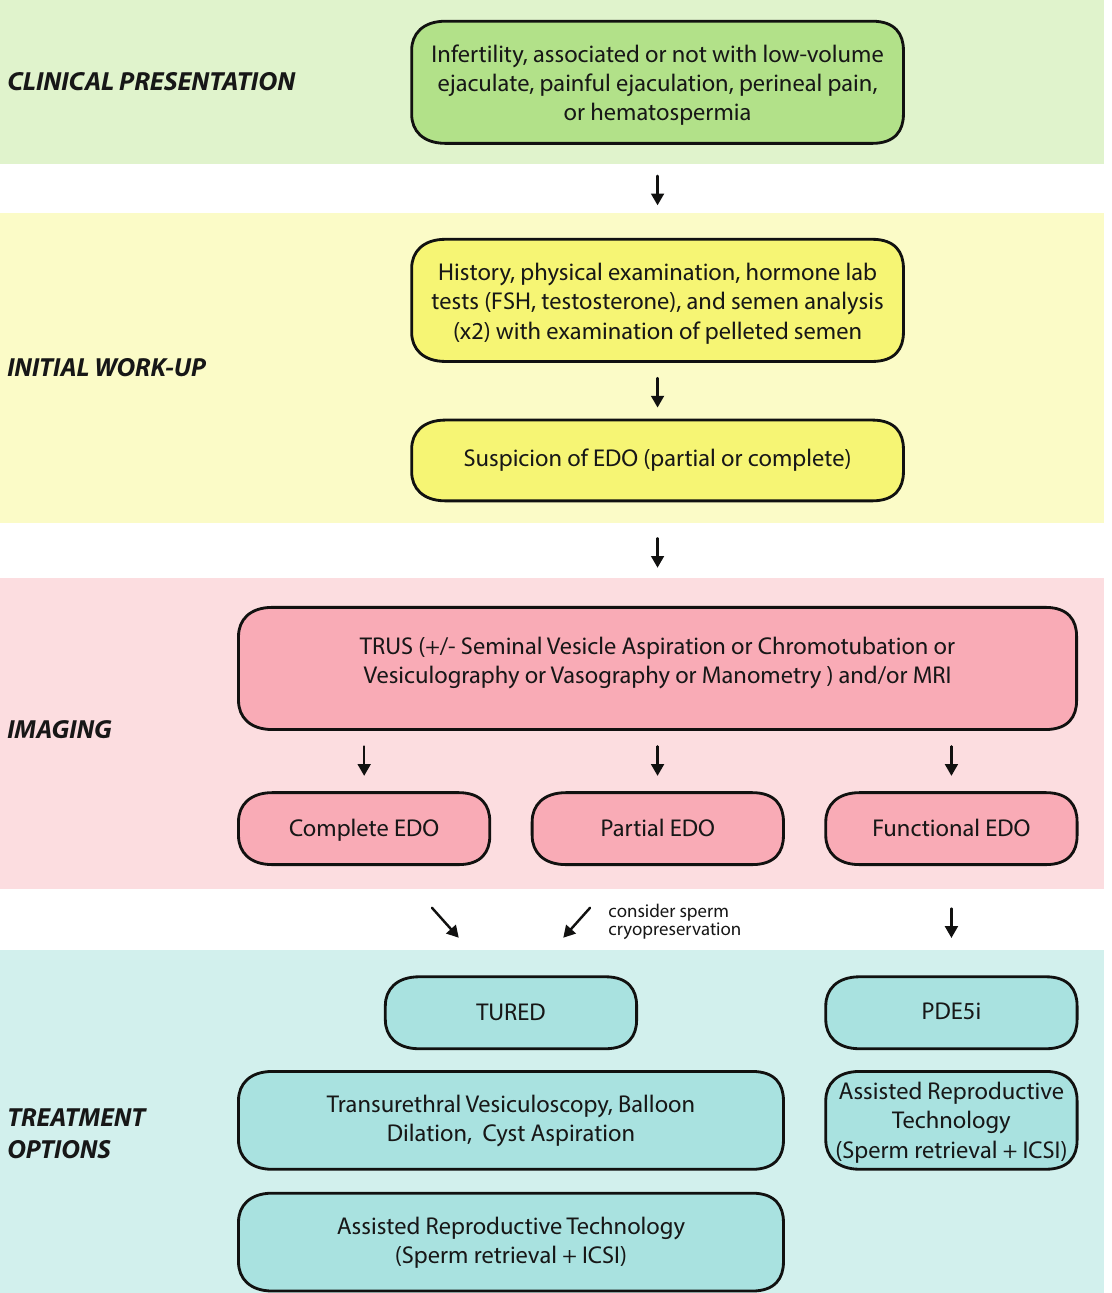
Figura 1 - Algorithm for the diagnosis and management of infertile with with ejaculatory duct